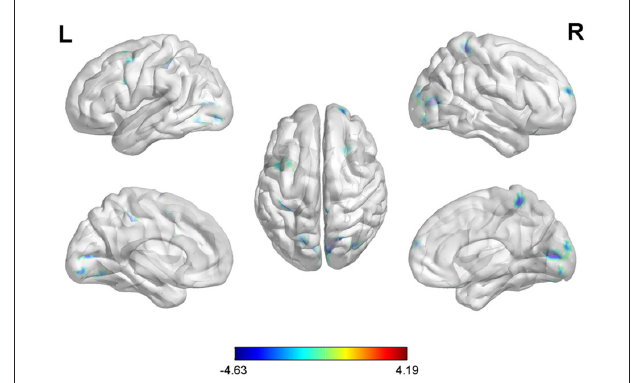
TABLE 3 | FC alterations between the two groups. Connected regions